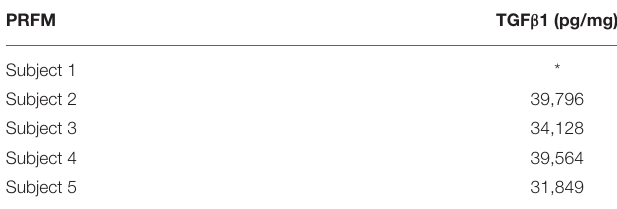
TABLE 4 | Level of TGF β